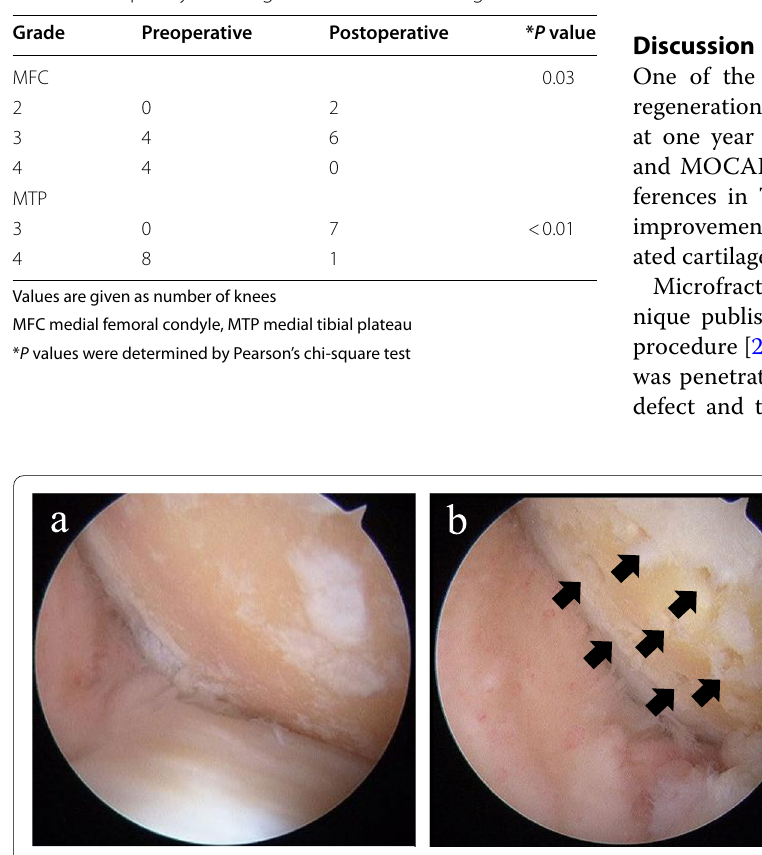
Table 2 Frequency of ICRS grade in articular cartilage